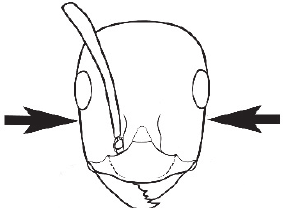
In profile, head of minor worker distinctly dorsoventrally flattened; in full- face view, head of minor worker extremely narrow, CI ≤ 75 (Lake Mere, NSW only, major worker unknown) (Fig. 40a–d) .................................... longiceps